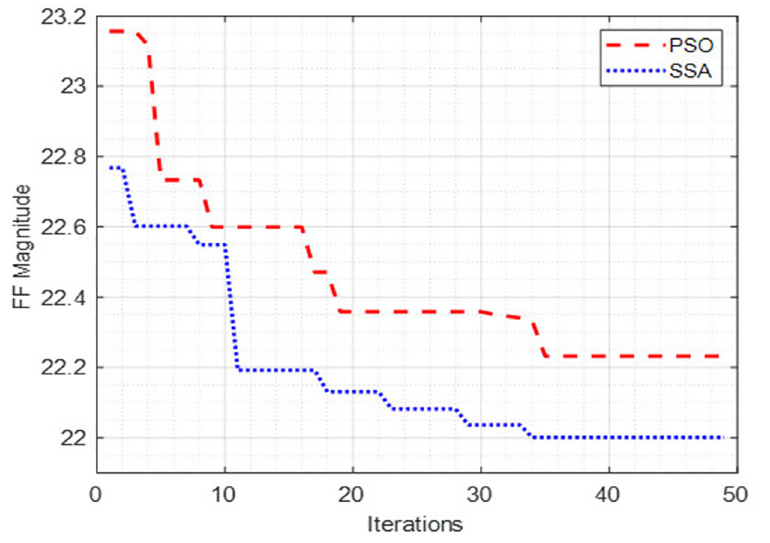
Fig 7. Convergence curve for PSO and